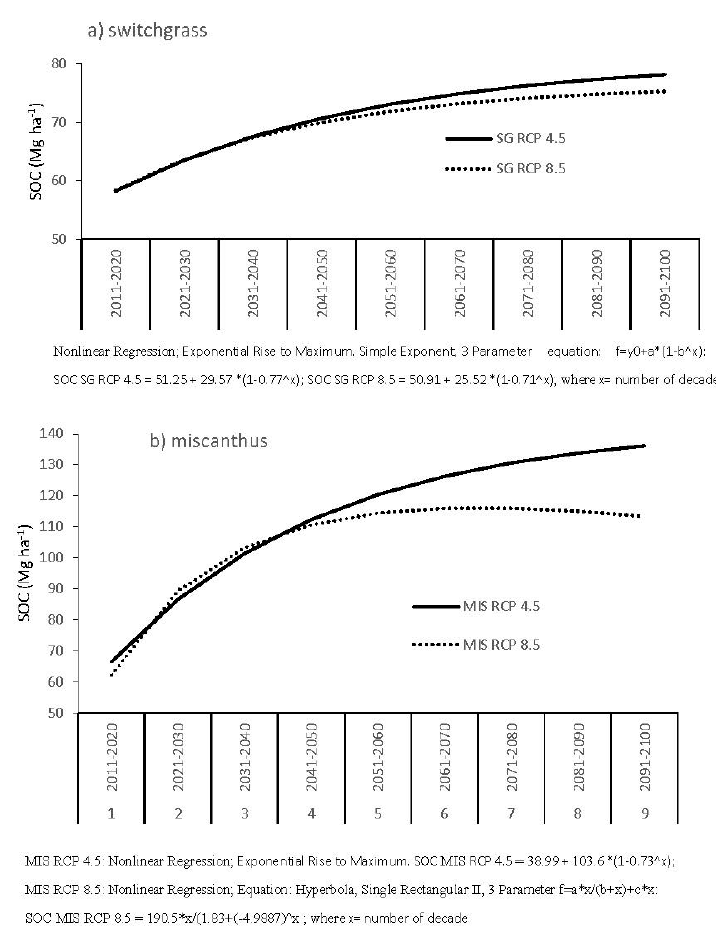
Figure 6. Soil organic carbon stocks. Nonlinear regressions for switchgrass ( a ) and miscanthus ( b ) based on DayCent prediction over investigated